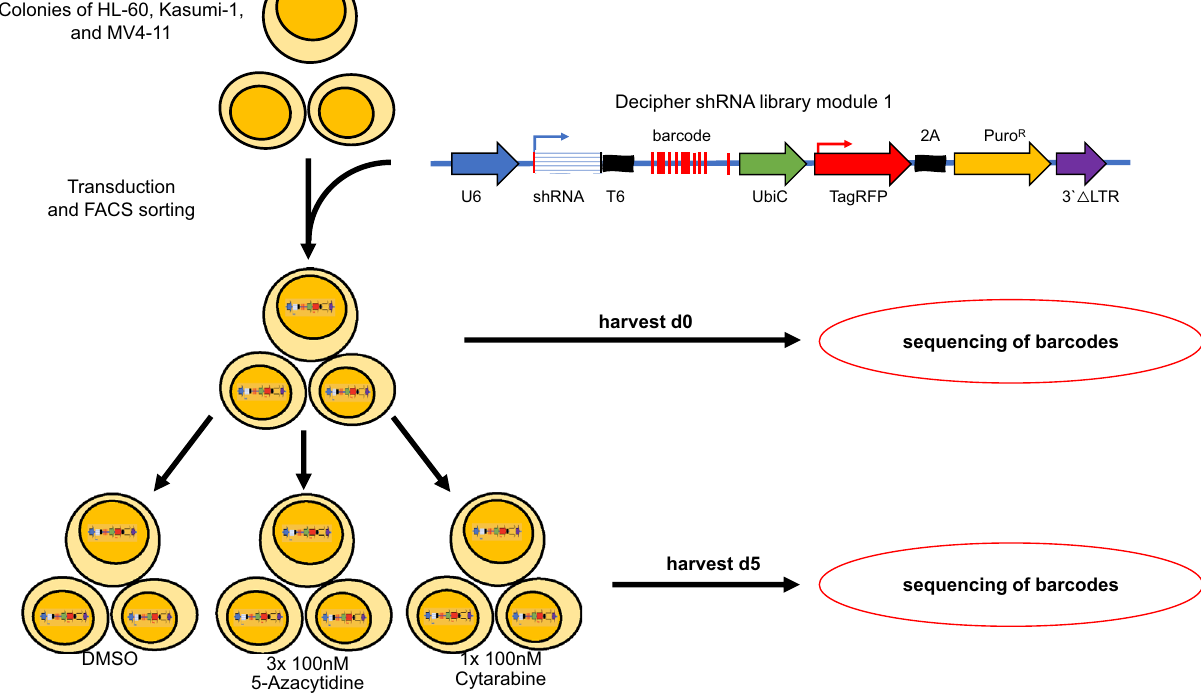
Figure 1. Pooled RNAi screens in leukemia cell lines and primary blasts. The in vitro shRNA screen was performed in three different cell lines and in primary leukemia blasts, resulting in ten independent experiments. Successfully transduced cells were selected via FACS sorting for TagRFP, expanded and subsequently exposed to either cytarabine, azacytidine or DMSO for 72 h. Cells were harvested at day 0 and day 5, genomic DNA was extracted and shRNA abundance was analyzed by next generation